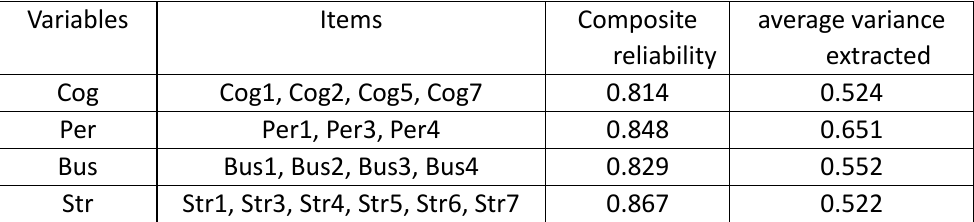
Table 4: Composite reliability and average variance extracted of CFA test